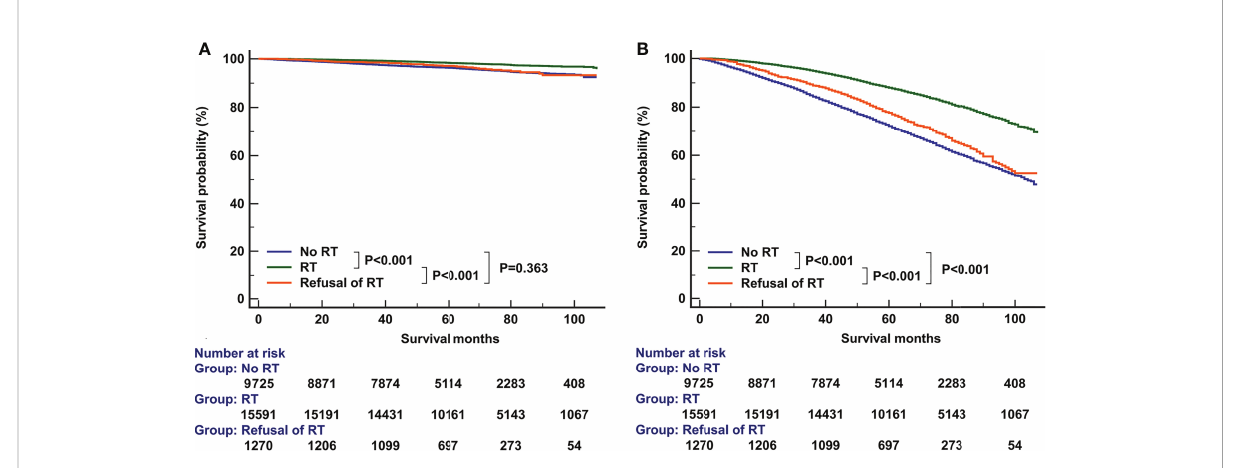
FIGURE 3 The effect of adjuvant radiotherapy on breast cancer-speci fi c survival (A) and overall survival (B) before propensity score